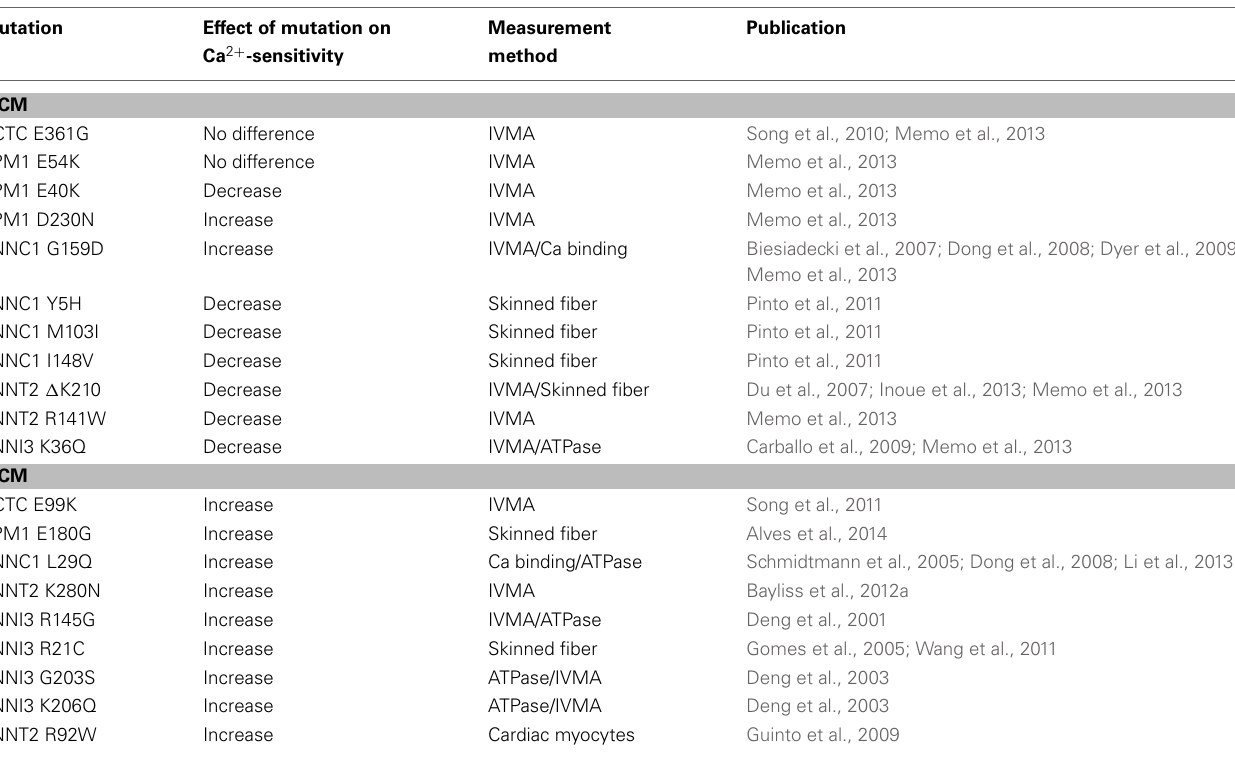
Table 1 | Mutations that have been reported to cause